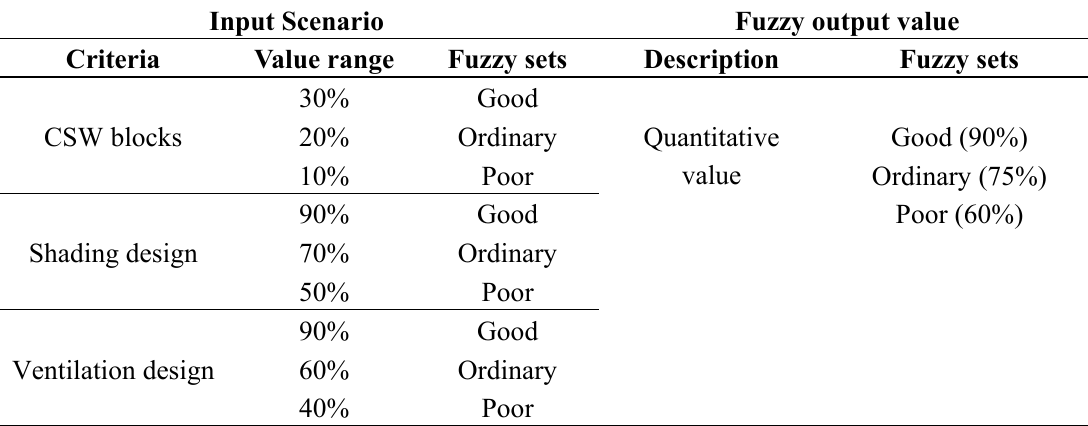
Table 6. Definition of the input and output fuzzy set and fuzzy range for the interior design criteria.